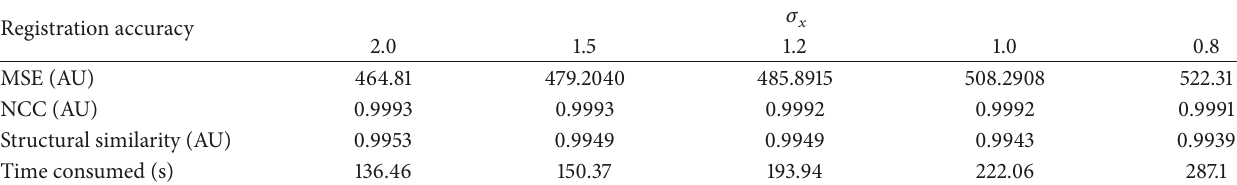
Table 5: Influence of parameter 𝜎 𝑥 on registration